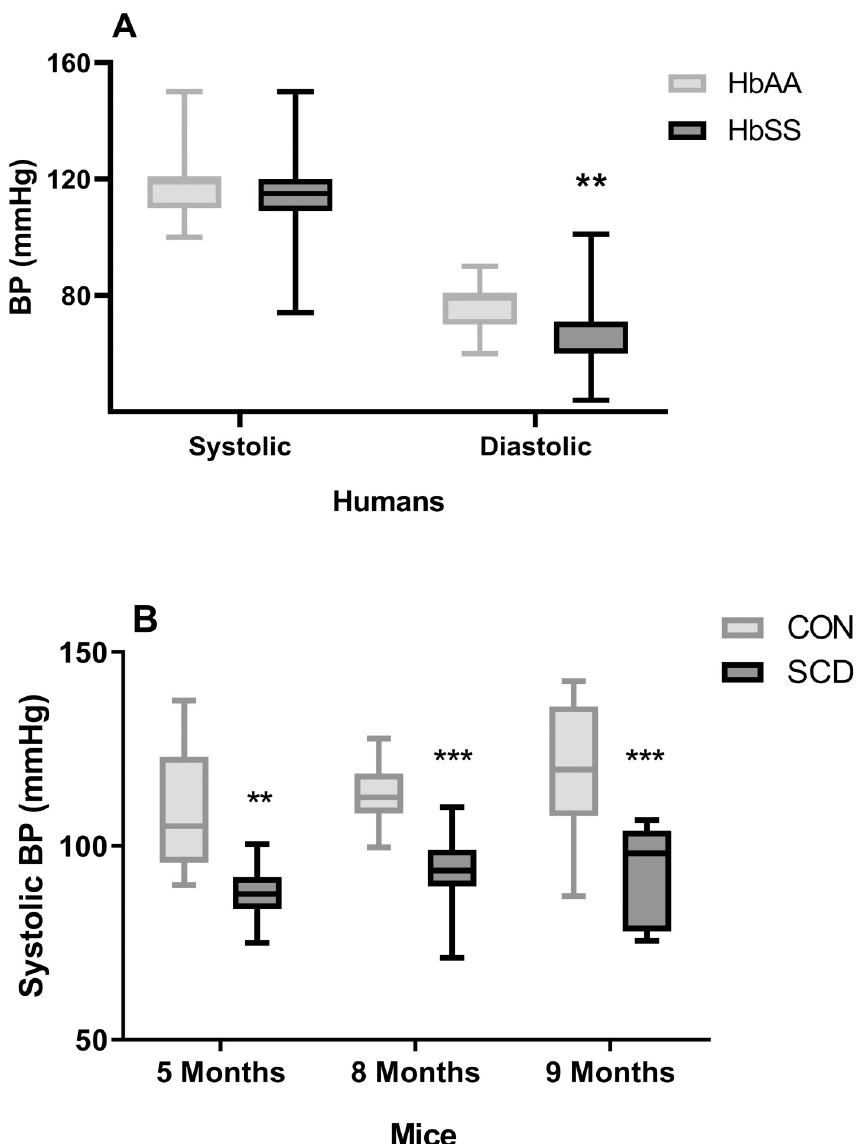
Fig 1. Blood pressure is reduced in human and murine sickle cell disease. (A) Systolic and diastolic blood pressures were determined in age-matched healthy control (HbAA, N = 35) individuals and patients with SCA (HbSS, N = 58). (B) Mean systolic arterial blood pressure (BP) was determined in SCD (SCD, N = 6–12) and control (CON, N = 10–14) chimeric mice at 5, 8 and 9 months of age, data are means of three measurements on three different days. �� , P < 0.01; ��� , P < 0.001, compared to HbAA or